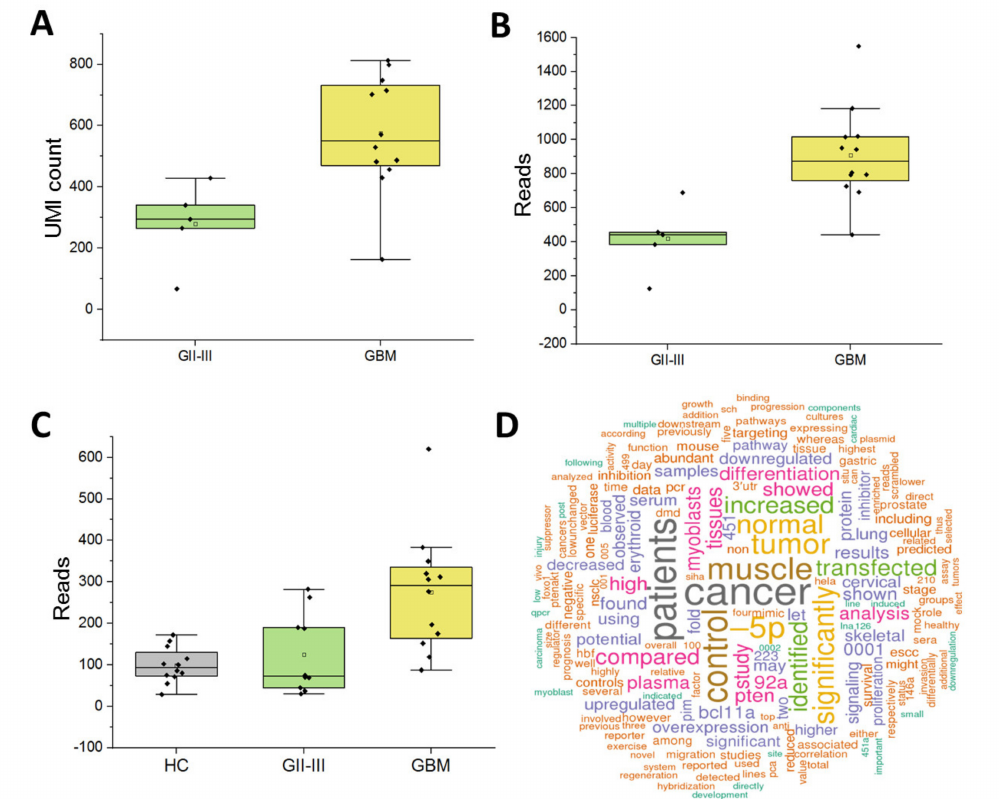
Figure 5. Expression of putative biomarker miR-486-3p across glioma cohorts. Box-plots show miR-486-3p expression in CUSA-EVs as ( A ) unique molecular identifier (UMI) counts and ( B) reads from GBM and GII-III patients. Number of miR-486-3p UMI counts and reads for individual patients (GBM [yellow] and GII-III [green]) are plotted (black dot); upper error bars signify the 90th percentile and lower error bars represent the 10th percentile, the middle line represents the median and the open square signifies the mean. ( C ) miR-486-3p expression levels in serum-EVs captured from GBM, GII-III and healthy controls (HC). ( D ) Word cloud for hsa-miR-486 (accession: MI0002470) generated by miRBase from 182 open access papers and 1080 associated